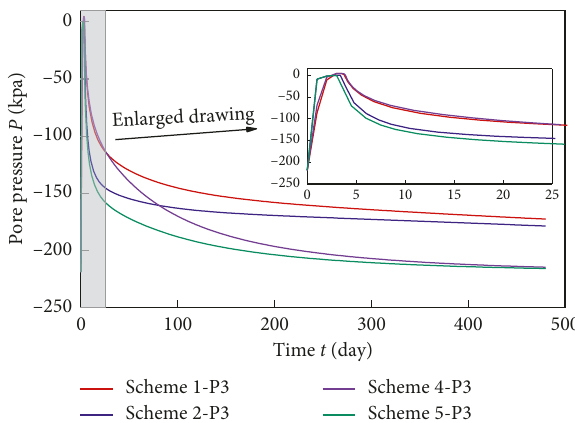
Figure 16: Variation curves of pore pressure at P3 with time in four